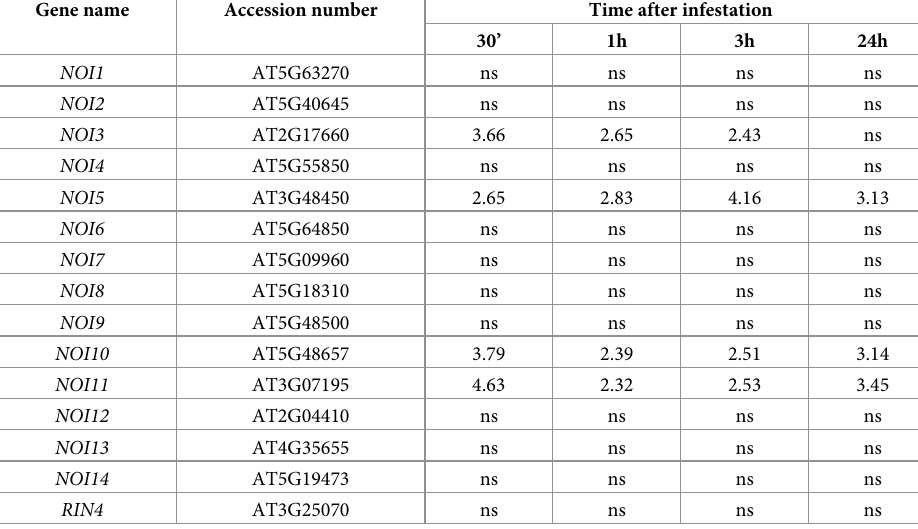
Table 1. Expression of NOI genes in A . thaliana infested with T . urticae